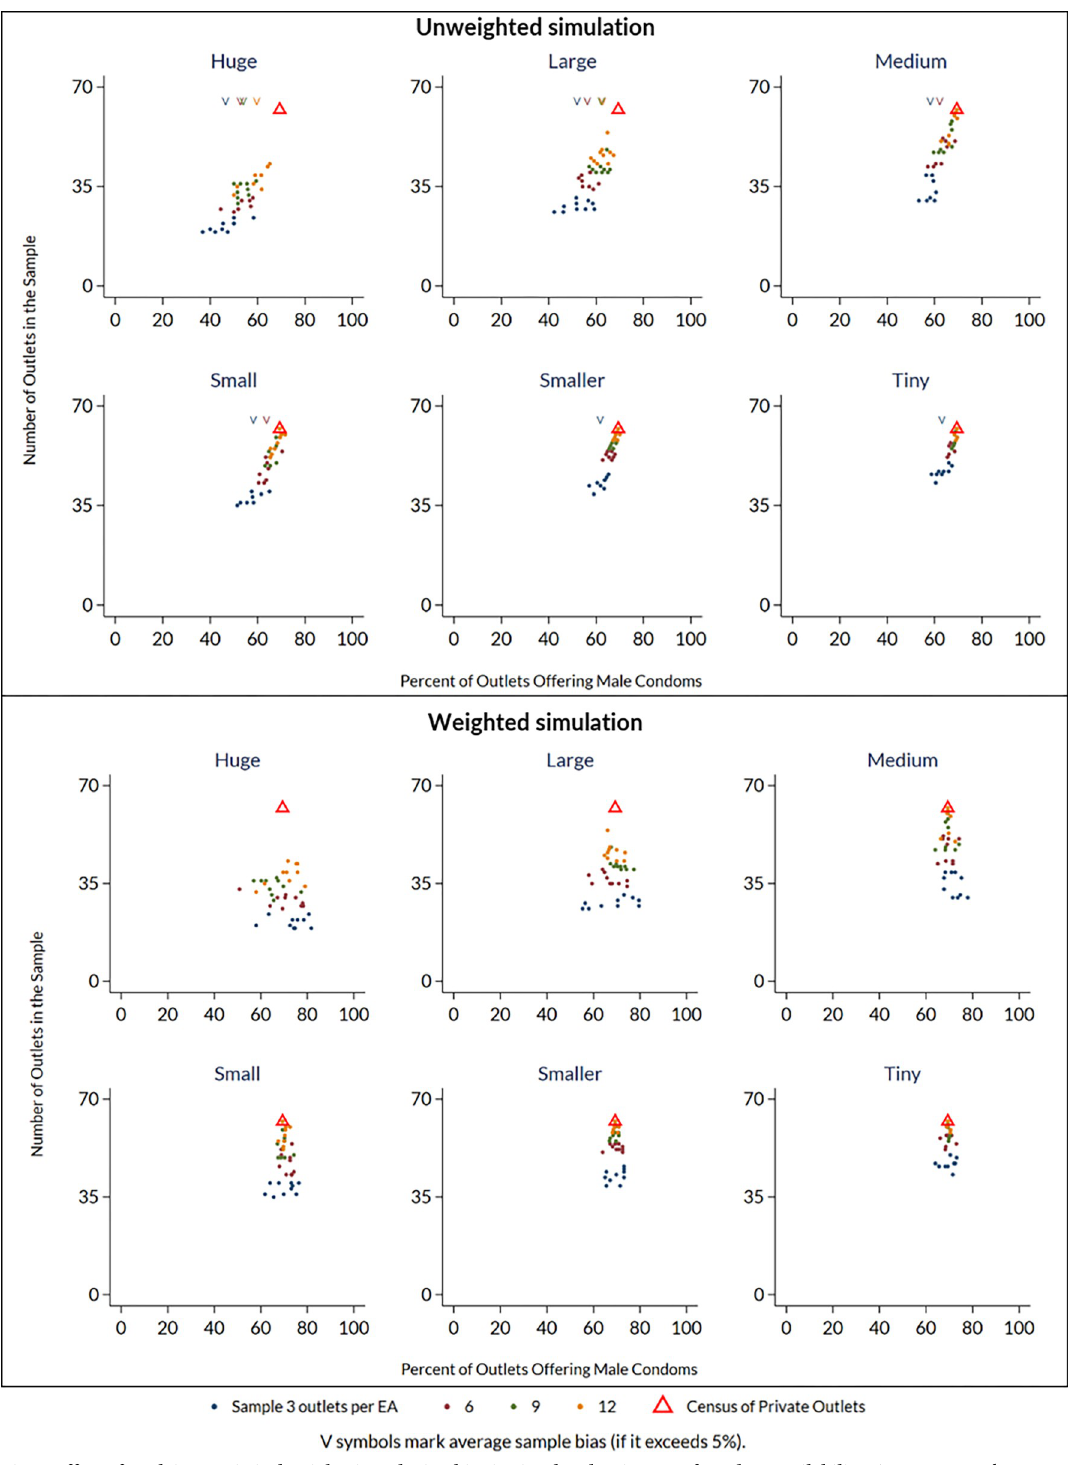
Fig 8. Effect of applying statistical weights in reducing bias in simulated estimates of product availability. As in Fig 4, each scatter cone plot depicts the census (true) availability measure as a red triangle, along with point estimates of availability from simulated samples that drew 3, 6, 9, and 12 outlets per EA. Simulations vary by sample size per EA and by relative size of pseudo-EA (huge, large, medium, small, smaller, and tiny). In scenarios where simulated samples show systematic bias, the points form an asymmetric shape. When bias of the simulated metric exceeds 5%, a downward-facing arrow denotes the simulated average at the top of the plot. The top